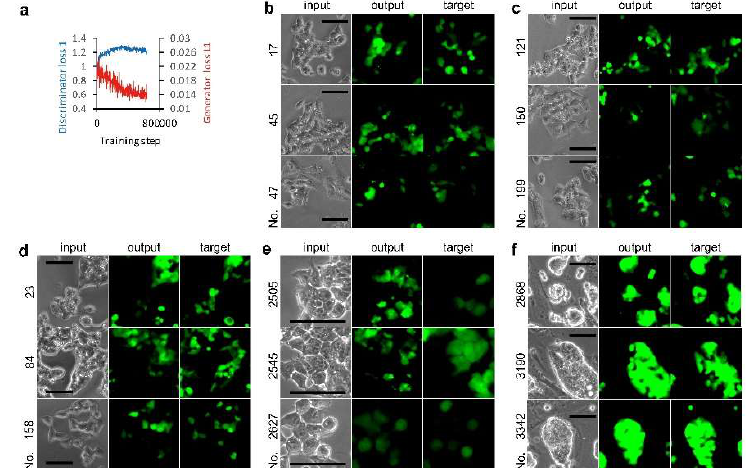
Figure 2. miPS-LLCcm cell image mapping from phase contrast to green fluorescent protein (GFP) fluorescence. ( a ) Effect of training steps on loss functions. ( b – f ) Output examples by AI models. Test phase contrast images were subjected to AI models for depicting fluorescence images. Input and target are the image of a pair for the evaluation of the depicted image. Images used for training AI for AI models: Set 1 images ( a , b ) without selection, ( c ) with selection of eliminating blanks, and ( d ) with selection of center; ( e ) Set 2 images with selection of eliminating blanks; and ( f ) Set 3 images with center selection. Bars = 100 μm.